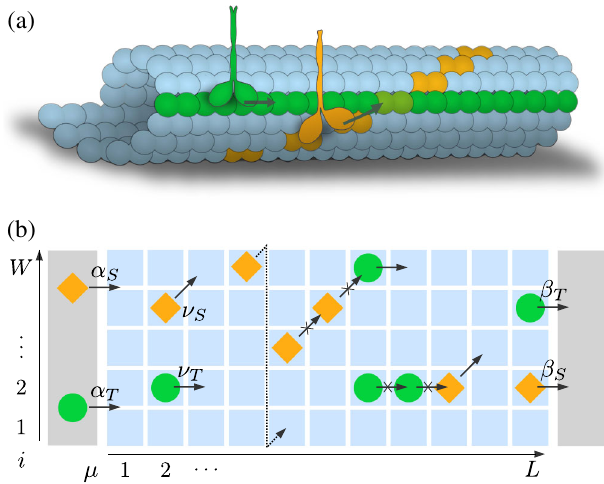
FIG. 1. Active transport by two species along a cylindrical structure. (a) Kinesins (e.g., kinesin-1, green) may track a single lane of a microtubule (protofilament), but many molecular motor species have also been reported to regularly switch protofilaments in a biased fashion and thereby effectively undergo a helical motion (e.g., kinesin-2, orange). (b) Model implementation to study collective two-species transport along cylindrical struc- tures. We consider a lattice with length L and width W . Periodic boundary conditions are employed along the transversal direction to account for a cylindrical geometry (e.g., microtubule). Particles of species T (lane tracking, green) hop to the neighboring lattice site on the right at rate ν T , and particles of species S (lane switching, orange) hop to the neighboring lattice site on the upper-right at rate ν S . All particles exclude each other. Particles enter the system with rates α T and α S at the left boundary and exit the system at the right boundary with rates β T and β S , respec- tively. Gray areas denote system